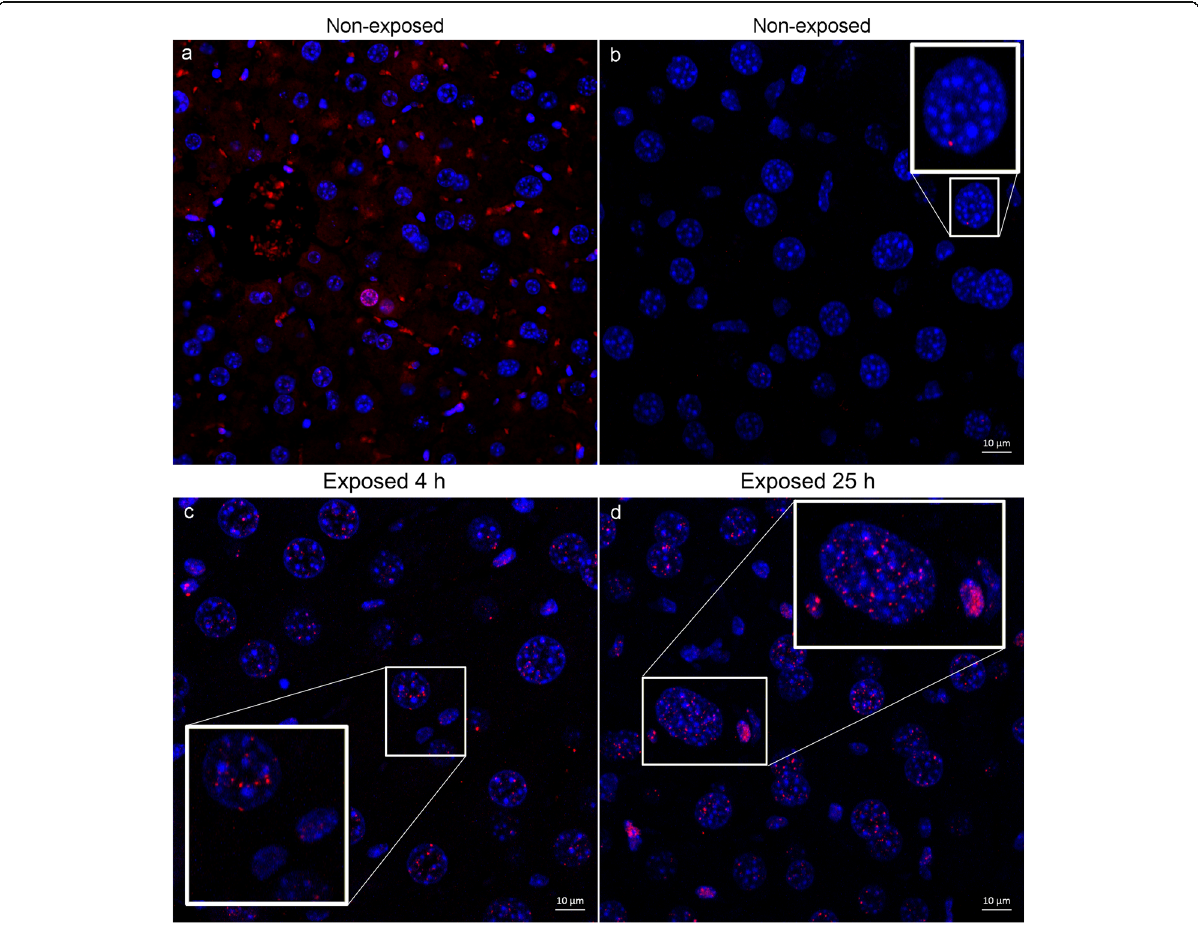
Fig. 2 Confocal laser microscopy of liver sections. Representative illustration of images from a , b non-exposed animals, c animal 4 h P.I., and d animal 25 h P.I. Overview image in a taken with wide-field fluorescence microscope and in b – d with CLSM. Note the difference between the hepatocyte nuclei, which morphologically are large, with a circular cell nuclei and bright areas of heterochromatin regions compared with the non-hepatocyte nuclei, which are more elongated in shape and have more homogeneous nuclear staining. Images were adjusted for brightness and contrast. Scale bars in b – d 10 μ